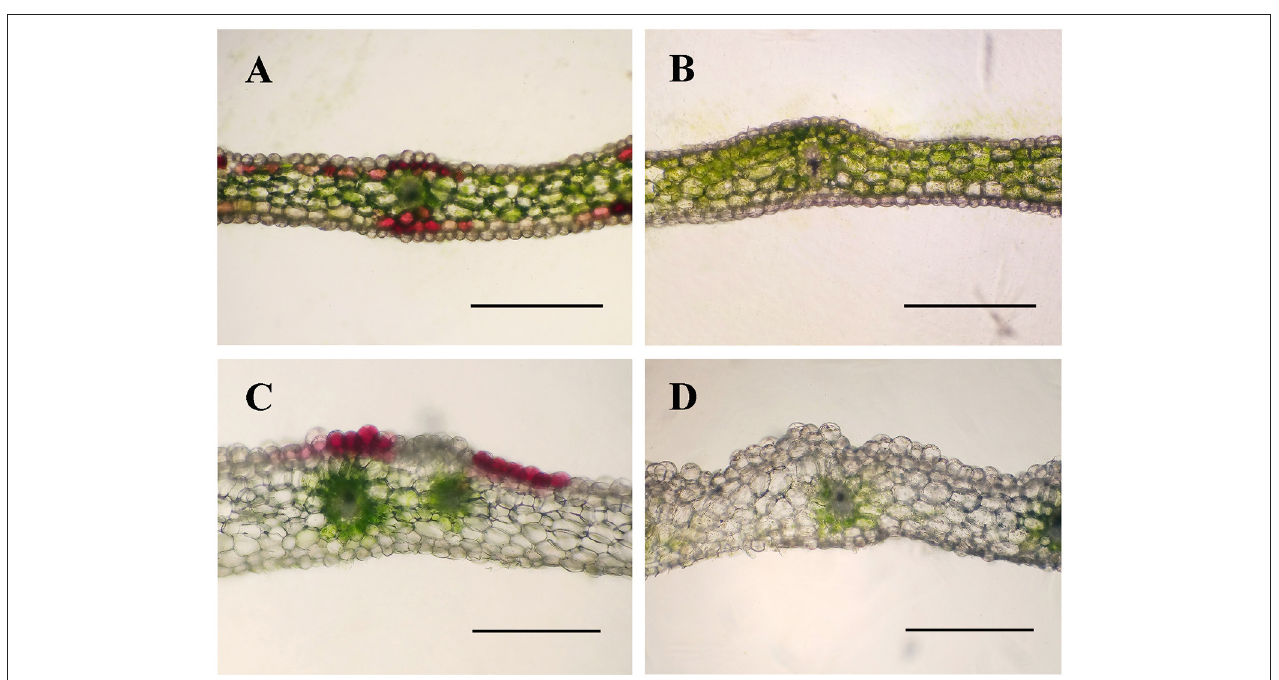
FIGURE 2 | Cross-sections of purple-red and white C. kanran showing the different colour patterns in petals and lips. Anatomic structure of purple-red C. kanran petals (A) and lips (C) , white C. kanran petals (B) , and lips (D) . Scale bar = 500 µ m.